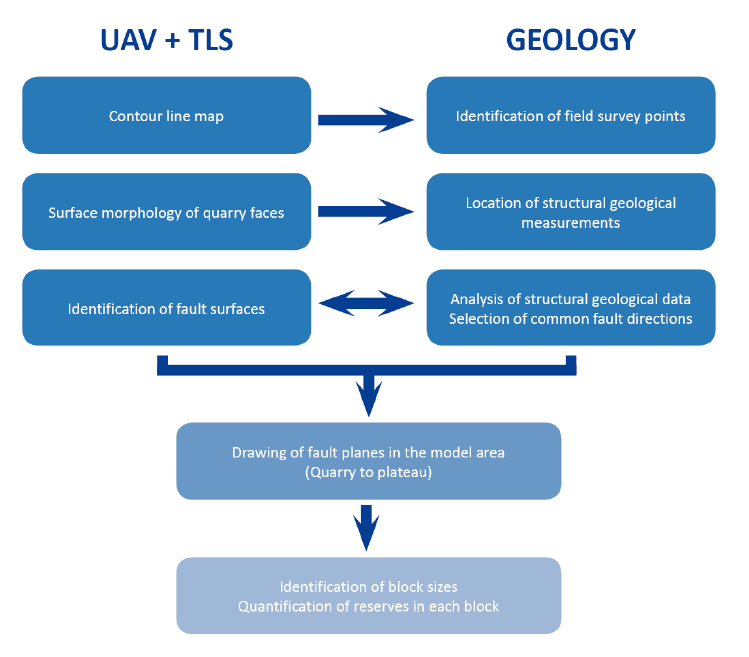
Figure 9. Application of UAV and TLS in structural geological measurements in this paper.